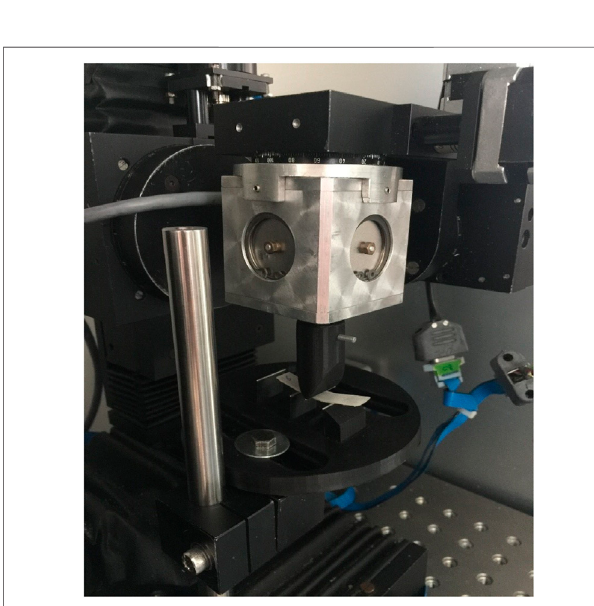
FIGURE4| Three-pointbendingtestofa4D-printedspecimenusingthe orthodontic measurement and simulation system (OMSS) at different temperatures.